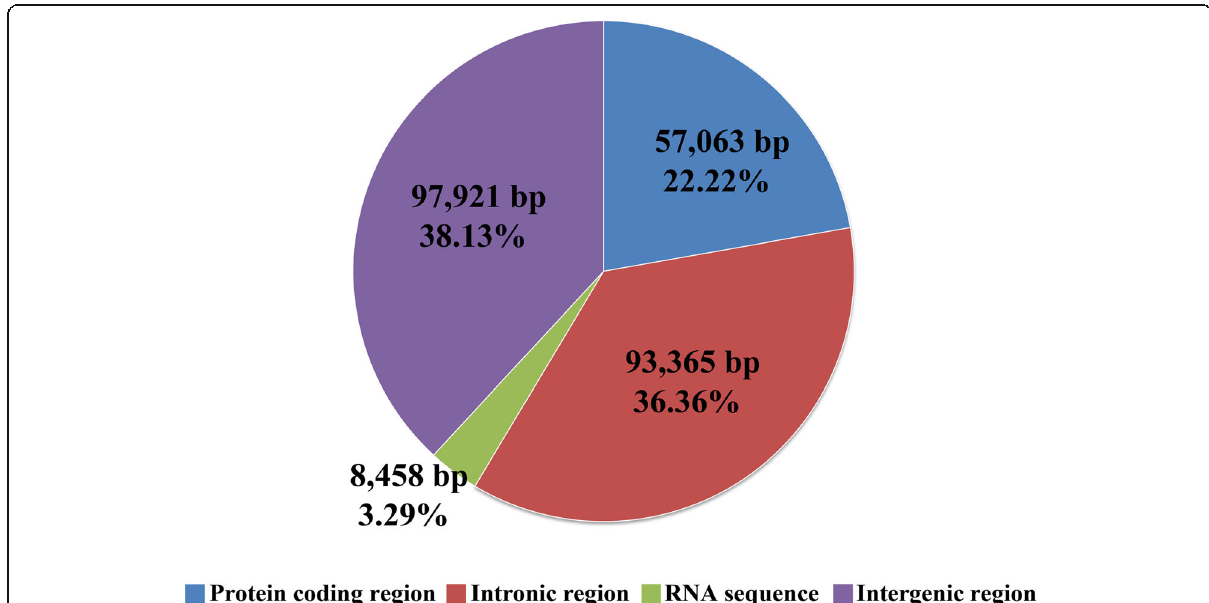
Fig. 2 The protein-coding, intronic, intergenic, and RNA gene region proportions of the whole mitochondrial genome of Clavaria